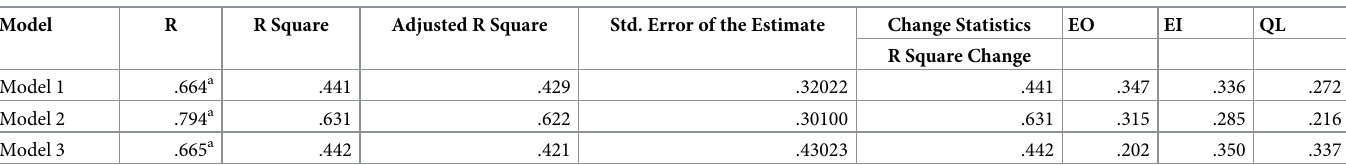
Table 9. Robustness checks for proposed